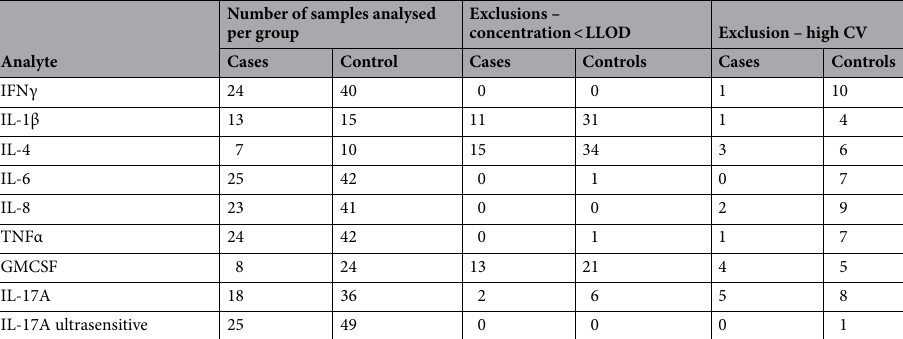
Table 3. Number of samples analysed and sample losses during processing. In this table we present the number of samples analysed for each analyte. Some of the cytokines had significant samples attrition during processing. The two reasons for loss of samples from the analysis were high CV values (> 25%) and undetectable concentrations of cytokine, below the LLOD of the assay. Use of an ultrasensitive assay rectified this issue in the case of IL-17A.